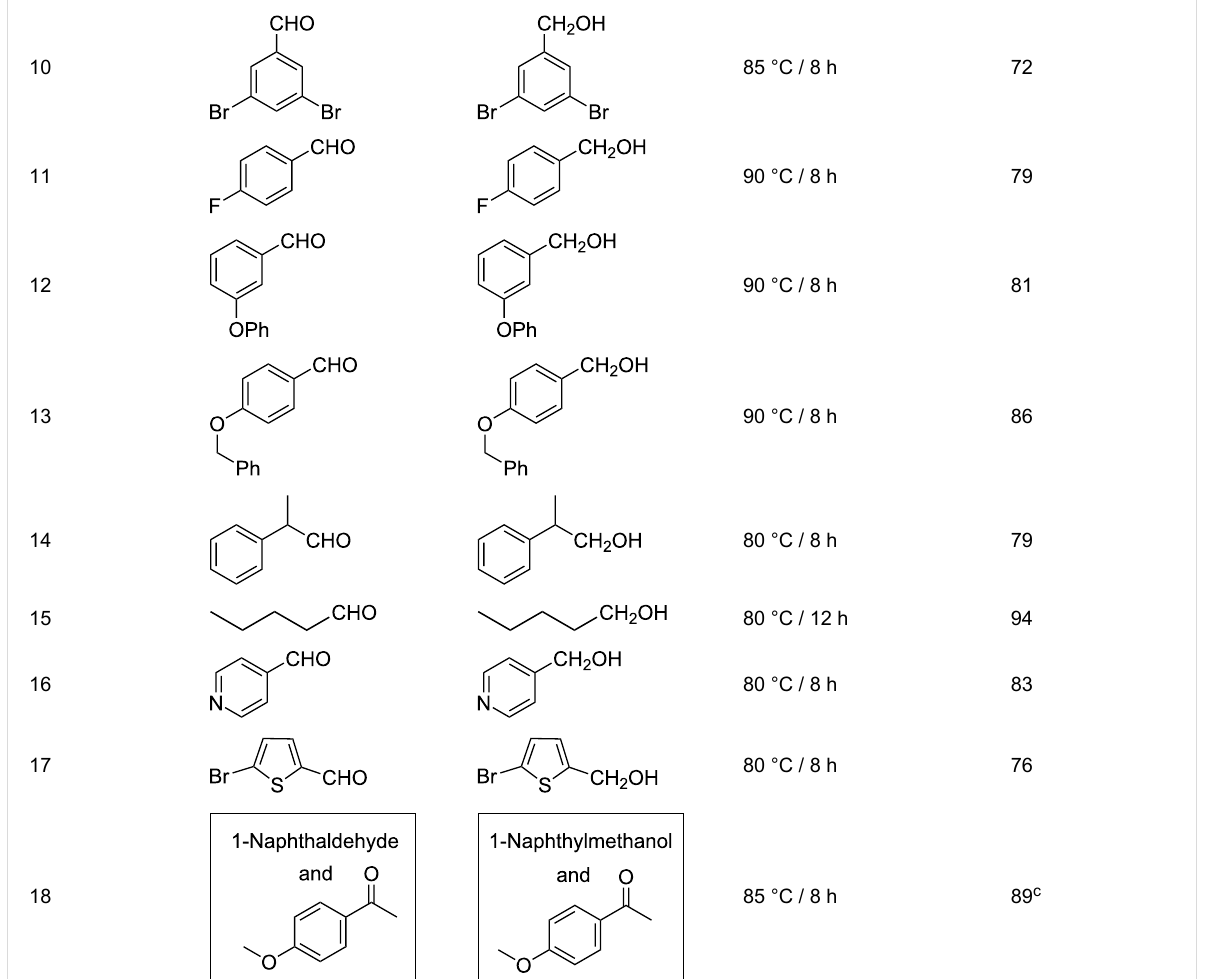
Table 2: Reduction of aryl aldehydes using resin-supported formate and catalytic RuCl 3 ·3H 2 O. (continued)